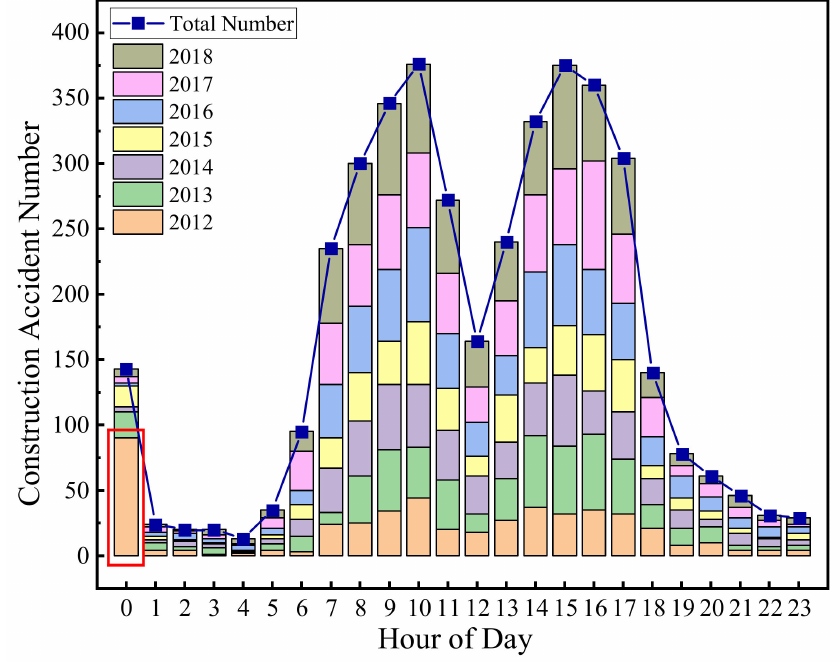
Figure 7. Number of construction accidents per hour of